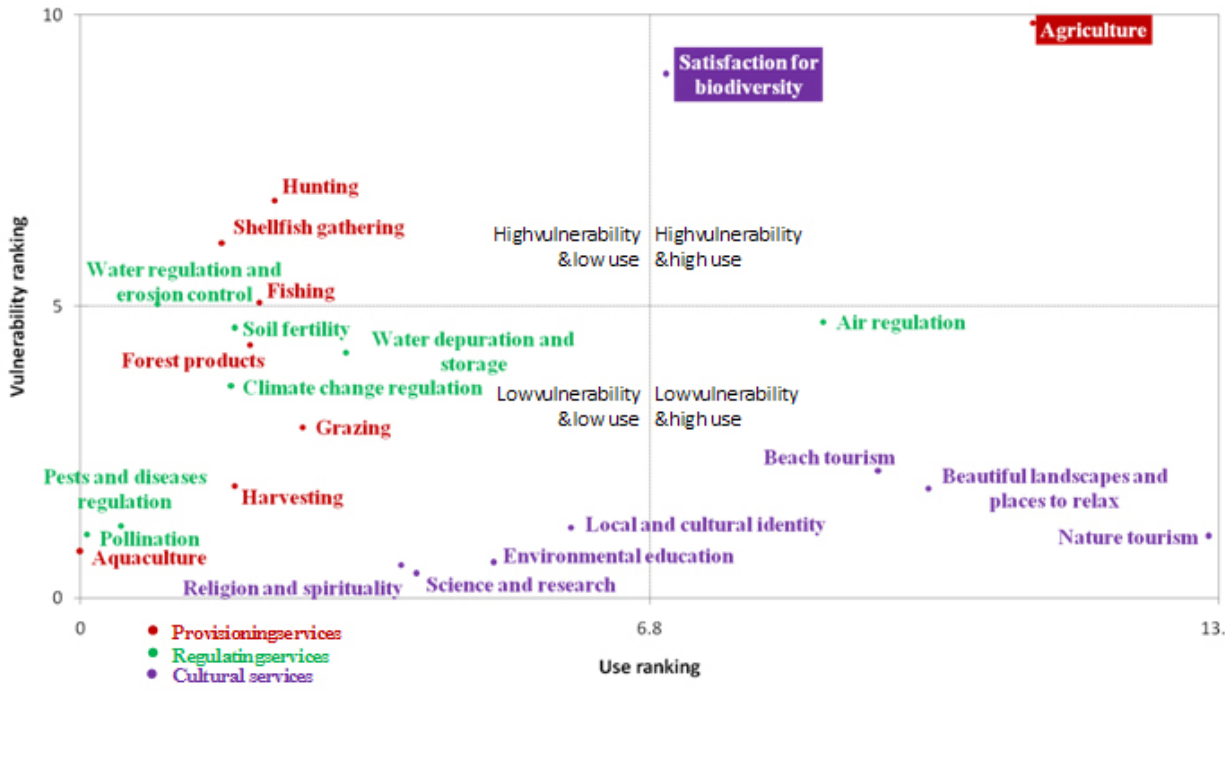
Fig. 3 . Dispersion diagram (a plot of the spread of values in a distribution) of the use of ecosystem services and their vulnerability according to respondents. The x and y axes represent the ranking of ecosystem services according to these variables. Satisfaction for conserving biodiversity and agriculture have the highest levels of use and vulnerability, making them the most critical ecosystem services to